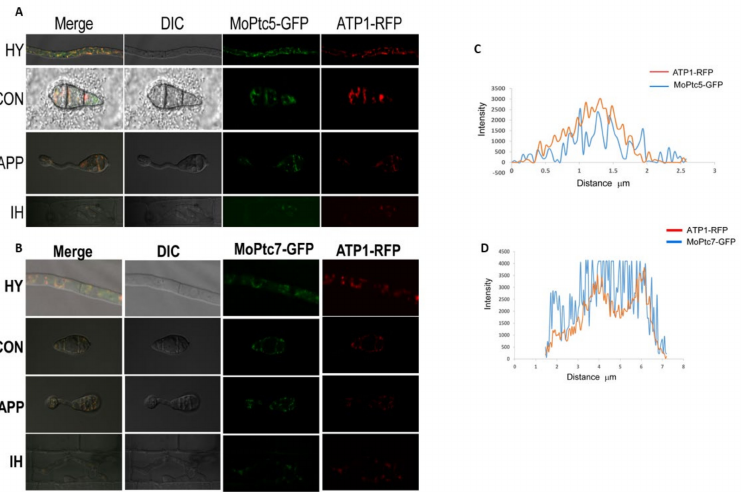
Figure 10. Localization of MoPtc5 and MoPtc7 in rice blast fungus. ( A , B ) displays co-localization of MoPtc5, MoPtc7 in hyphae, conidia, appressorium and in plantae as it co-localizes with ATP1_RFP (Red Fluorescence Protein) mitochondria marker. ( C , D ) graphs representing intensity fluorescence and distance for MoPtc5 and MoPtc7 co-localization. The pictures were taken by a NikonA1 confocal microscope (Scale bar = 20 µ